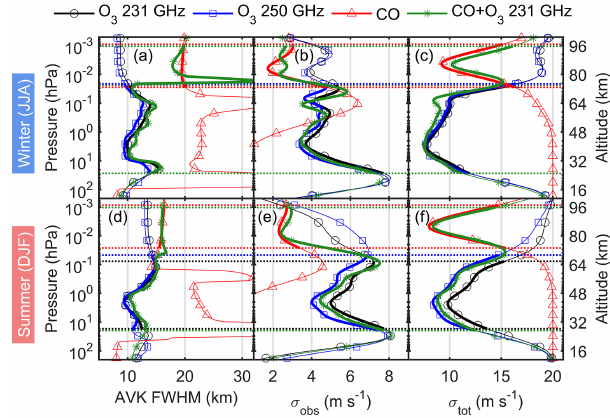
Figure 11. As Fig. 7, but for different total measurement times and a 60 ◦ zenith viewing angle.